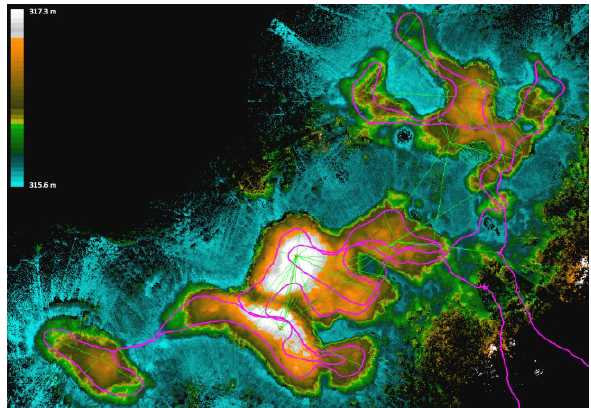
Figure 7. Assessing MLS data accuracy with spherical targets (red circles). Purple line shows the MLS trajectory, green lines connect the targets to trajectory locations from where the targets were detected.